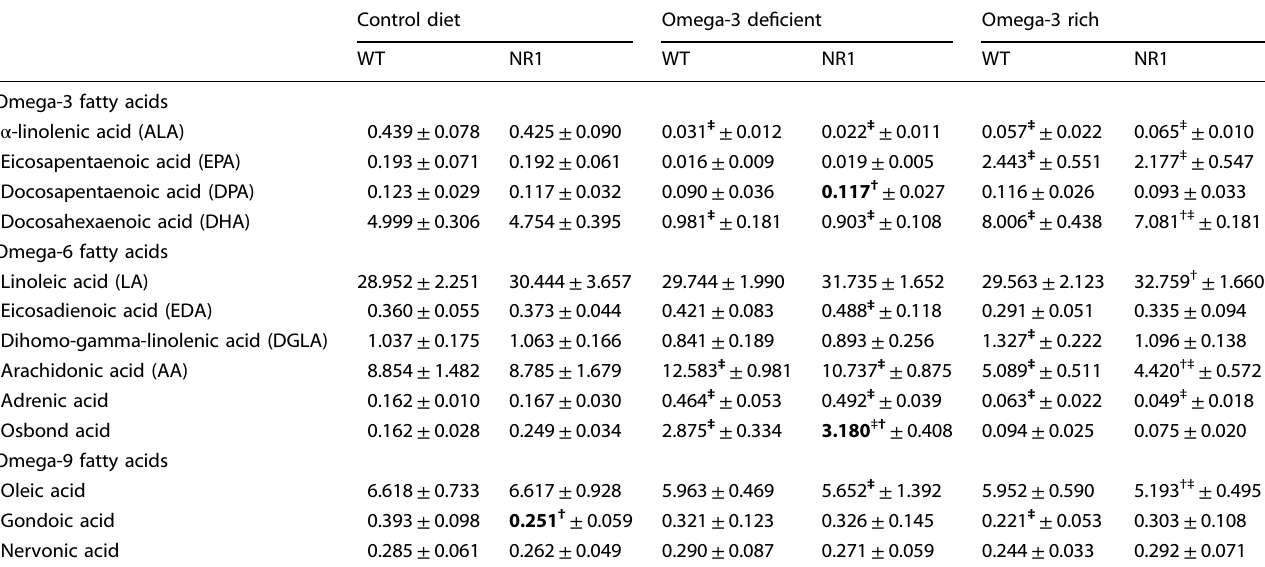
Table 2. Serum fatty-acid pro fi le of WT and NR1KD mice on experimental